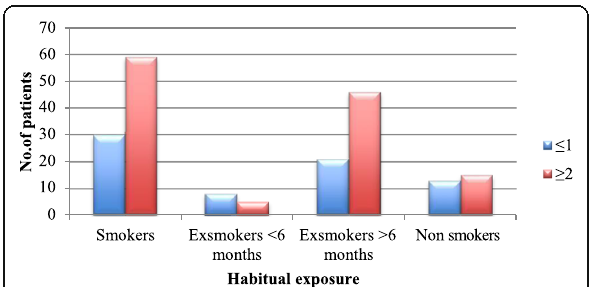
Fig. 7 Distribution of occupational exposure with